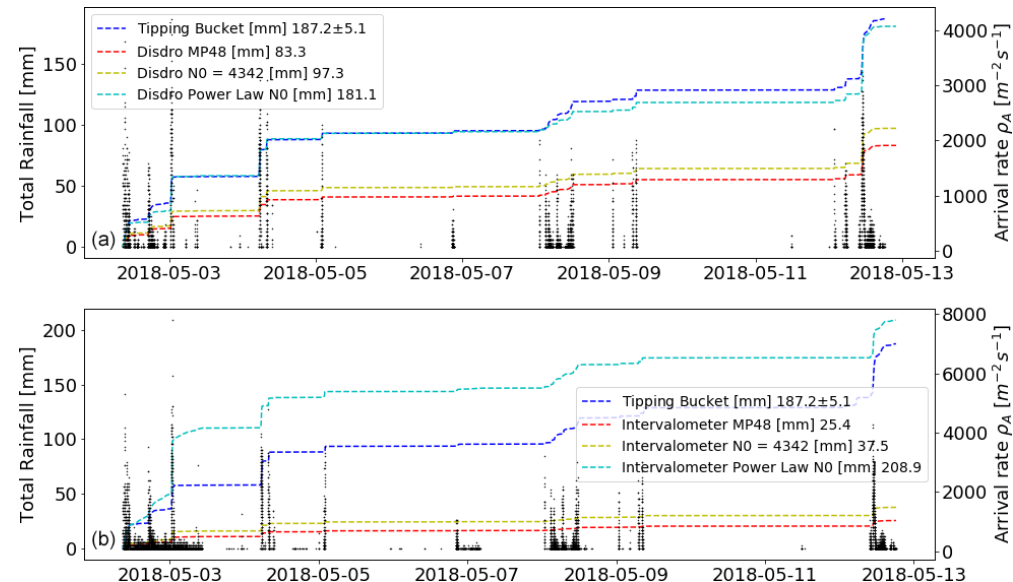
Figure 6. The total rainfall amount [mm] observed by the co-located tipping bucket, intervalometer and disdrometer at the main site (Pole Pole) for the longest “online” period of the three instruments. Panel (a) compares the three DSD parameterisation estimates of rainfall to the observed tipping bucket rainfall amount for the disdrometer data. Panel (b) compares the three DSD parameterisation estimates of rainfall to the observed tipping bucket rainfall amount for the intervalometer data. Also plotted are the rainfall arrival rates measured by the disdrometer and intervalometer.